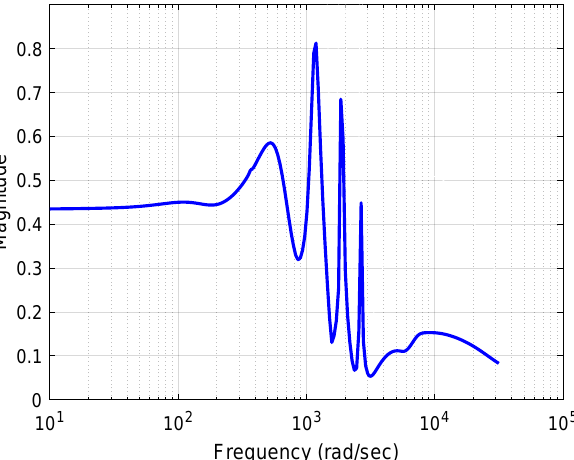
Figure 10. Robust control condition for the sequential design in Equation (14) (Step 3 of the proposed 5-step design